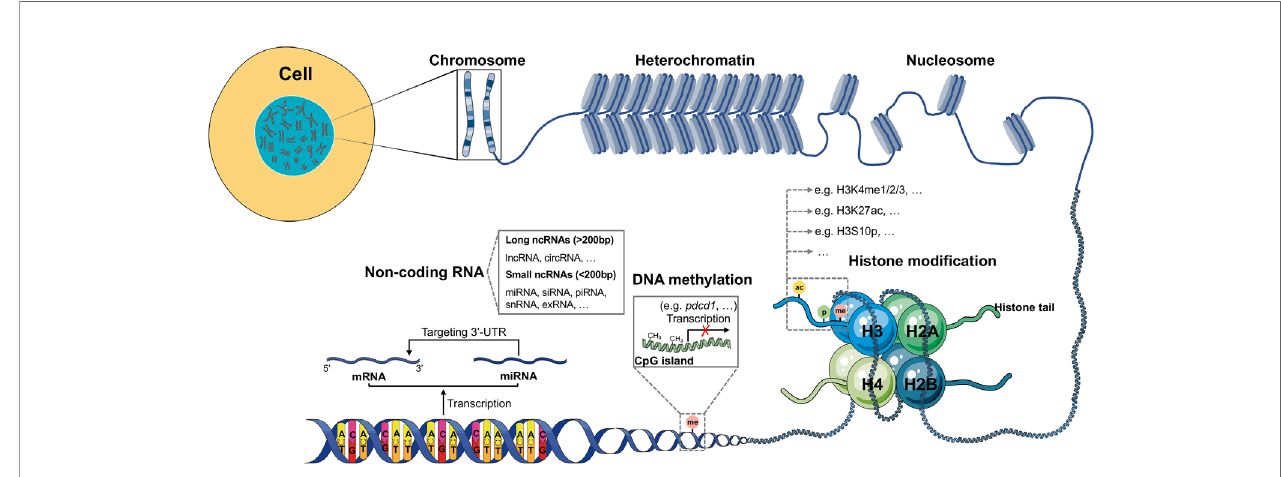
FIGURE 1 | Schematic model of epigenetic regulation. The expression of most human genes is regulated by epigenetic modi fi cations. There are three different epigenetic processes that control gene transcription and expression: DNA methylation, histone modi fi cation and ncRNA. DNA methylation always exists in GC-rich areas of the human genome called CpG islands, which can be methylated by DNMTs, resulting in failed transcription of genes, such as pdcd1 . Histone modi fi cation, in which amino acids on four different histone tails (H2A, H2B, H3, H4) can be modi fi ed by different enzymes (KMTs, HATs, phosphatases, KDMs, HDACs, among others), results in the regulation of gene expression. In the human genome, many DNA sequences cannot be transcribed into mRNAs but are transcribed as ncRNAs. According to the length, ncRNAs can be divided into small and long ncRNAs. The most investigated ncRNA is miRNA, which targets the 3 ’ -UTR of mRNA, thus contributing to gene